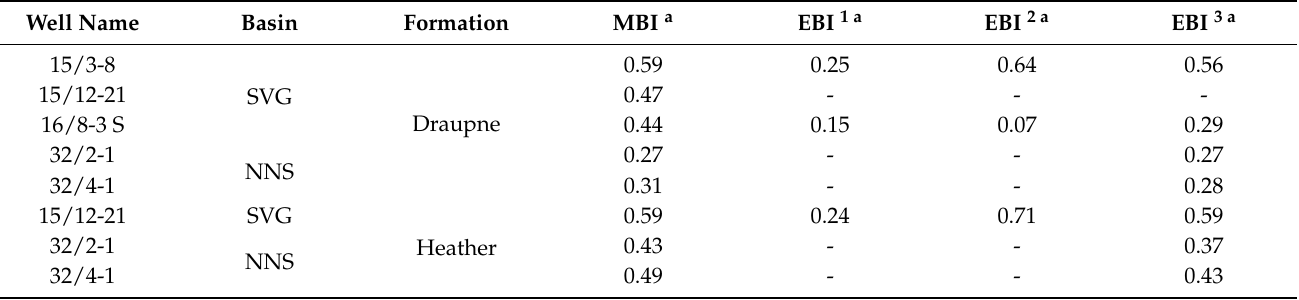
Table 3. Comparison of the brittleness indices of the Upper Jurassic caprock. (SVG = South Viking Graben; NNS = Northern North Sea; NDB = Norwegian Danish Basin and SWBS = South West Barents